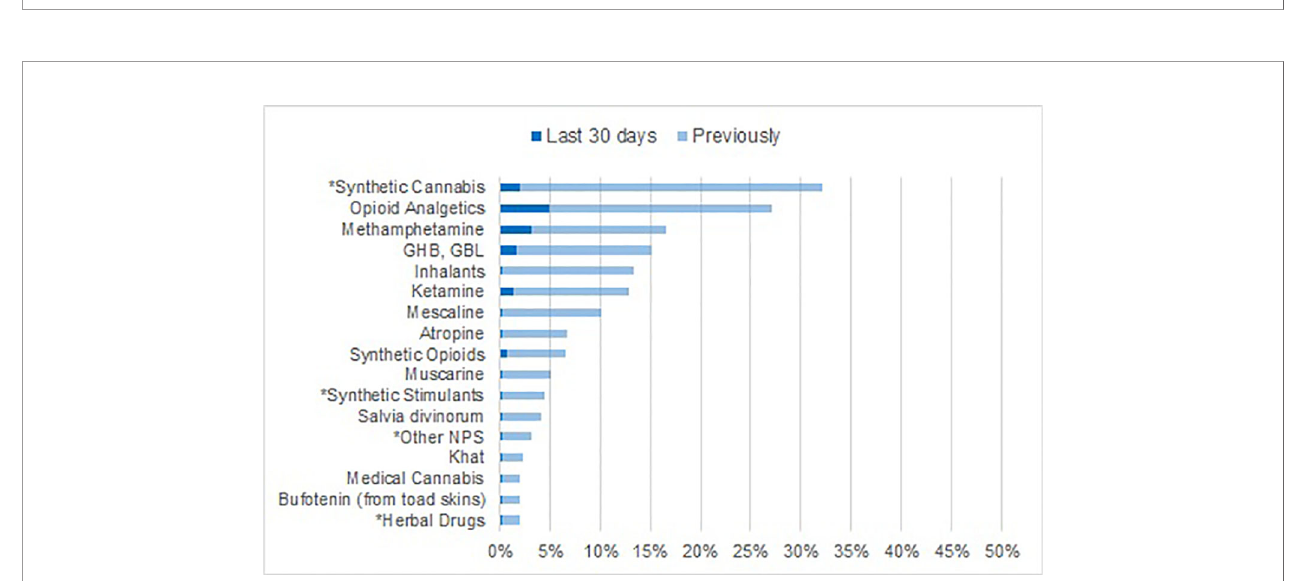
FIGURE 1 | Top 10 of lifetime prevalence of substances of abuse, and their recent use.